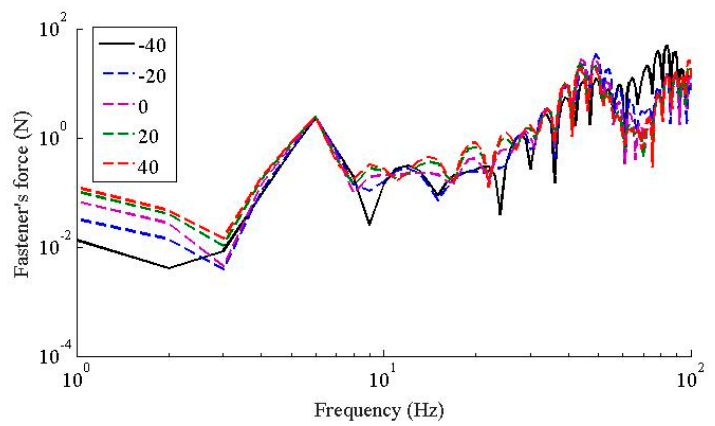
Figure 11. The WJ-7B small resistance fastener’s force under − 40, − 20, 0, 20, and 40 °C.